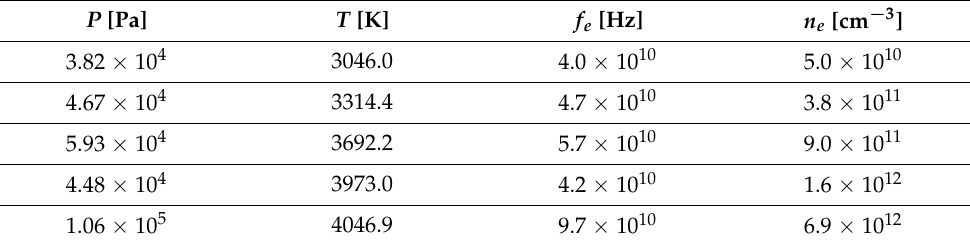
Table 1. The parameters of the gas in the second area, electron density and collision frequency (with pressure and temperature), at 100 GHz.